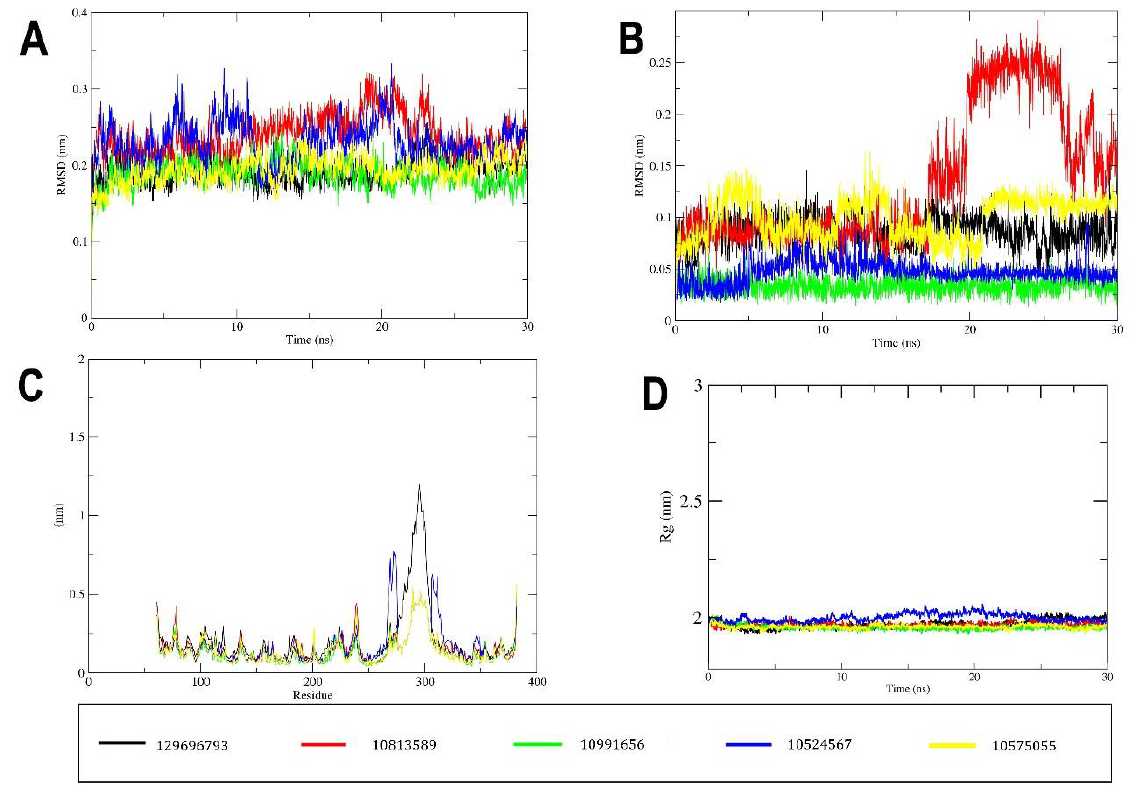
Figure 5. MD simulation results of the docked flavonoids obtained from virtual screening. ( A ) Root–mean–square deviation (RMSD) curve for the protein backbone of the protein–ligand complex. The RMSD plot provides quantification of the overall stability of the protein backbone during 30 ns simulation. ( B ) RMSD curve for ligands’ heavy atoms through the simulation. ( C ) Root–mean–square fluctuations’ (RMSF) curve of the MEK1 residues for the protein–ligand complexes. ( D ) Radius of gyration (total) of protein–ligand complex.